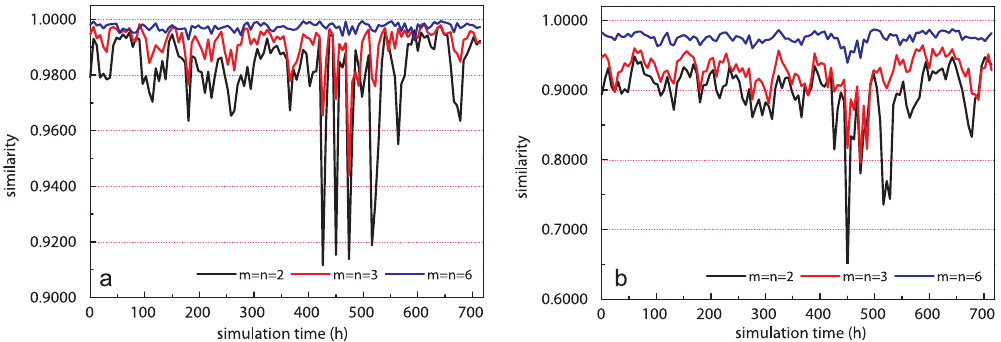
Fig. 6. Time series plots of similarity of horizontal kinetic energy at 850hpa for January 2010 by spectral nudging with different wave numbers. (a) similarity between NCEP/NCAP and downscaling results by WRF at 2000km scale; (b) similarity results at 300km scale.